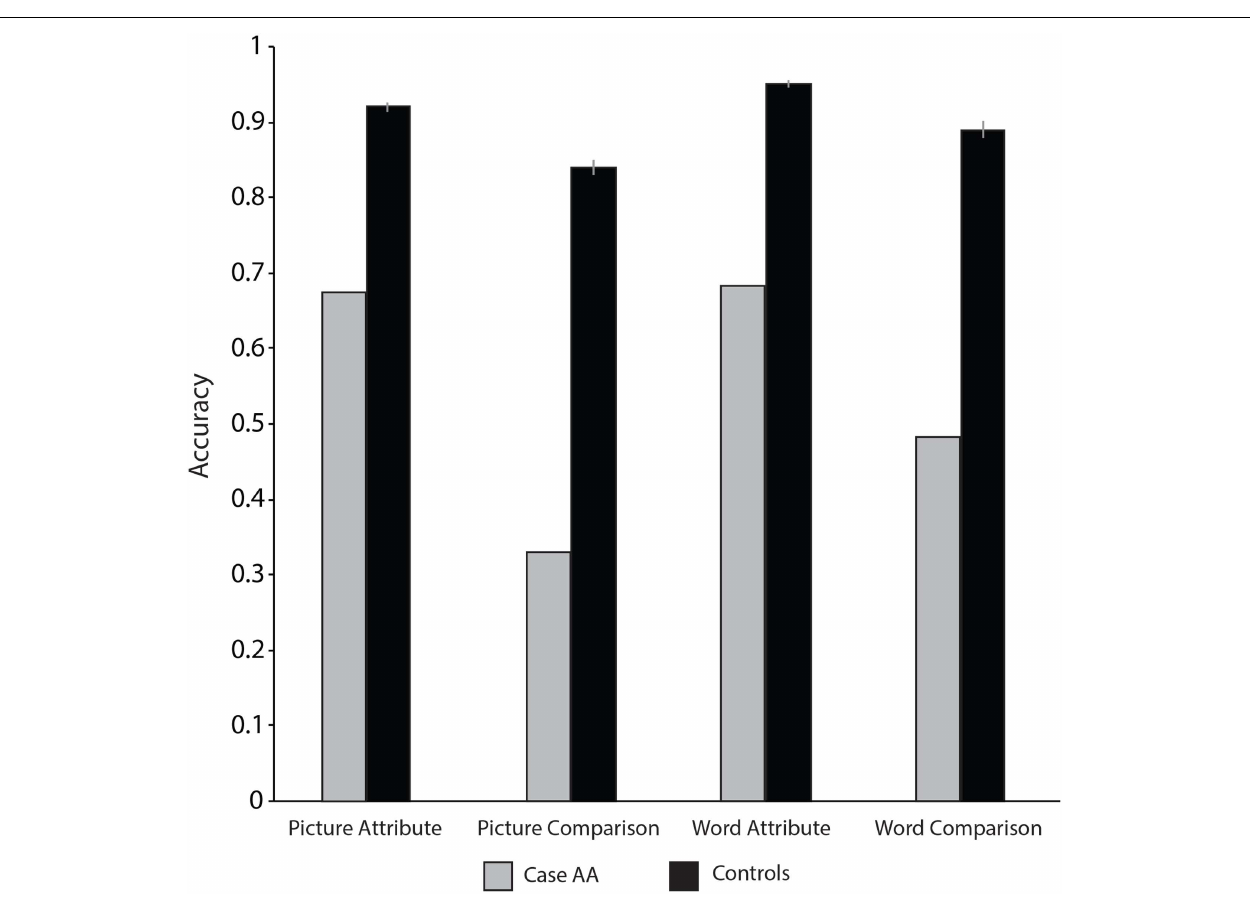
FIGURE 5 | CaseAA and controls’ accuracy for attribute knowledge of